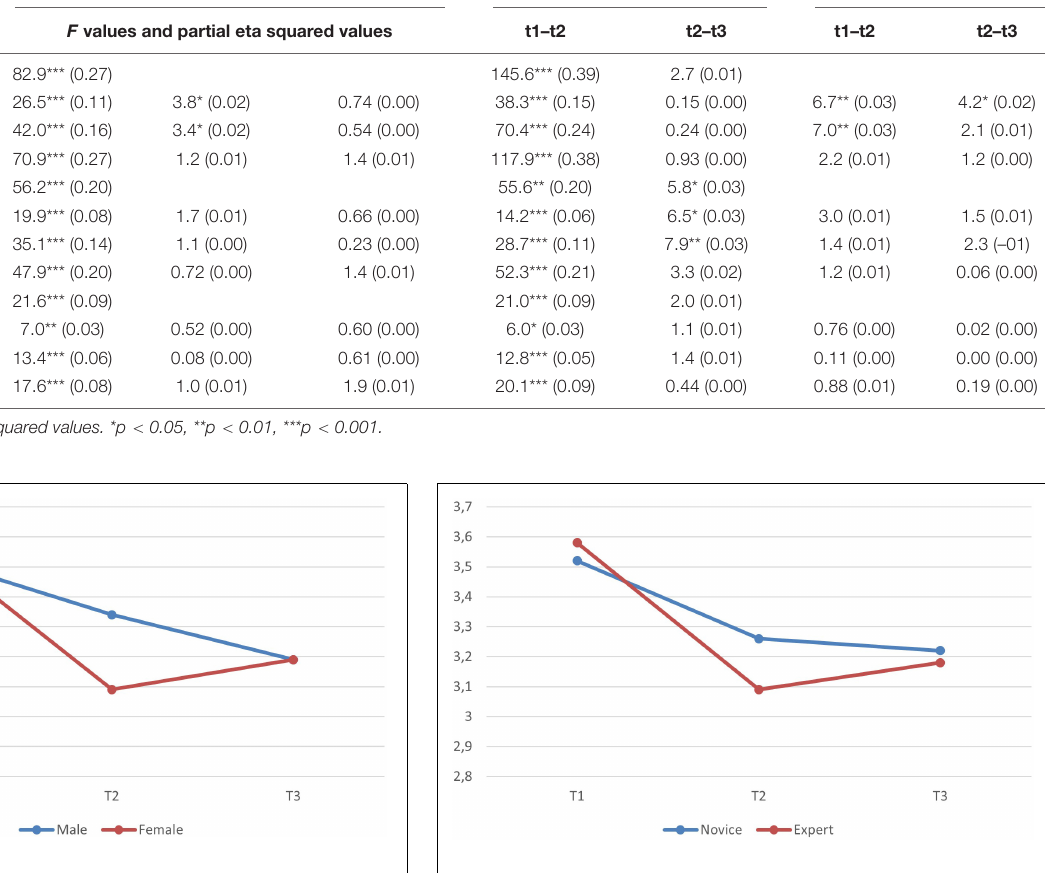
FIGURE 2 | The relation of gender to development in job satisfaction. FIGURE 3 | The relation of expertise to development in job